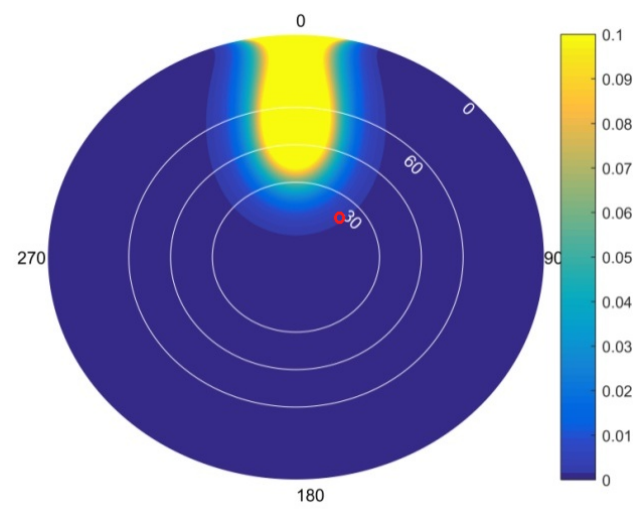
Figure 13. The sun glint distribution in terms of SGR and wind speed: the solar zenith angle (SZA), view zenith angle (VZA), view azimuth angle (VAA), wind speed, and wind direction are 49°, 22°, 145°, 5.3 m/s, and 2°, respectively. The red circle shows the SPOT6 view conditions acquired from the website: https://www.intelligence-airbusds.com/en/4871-ordering.